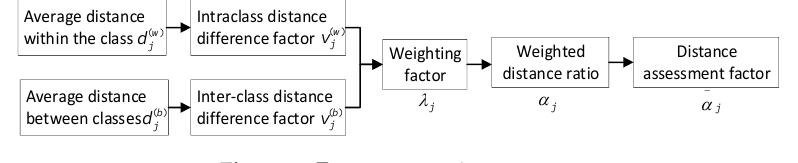
Figure 4. Feature screening process.